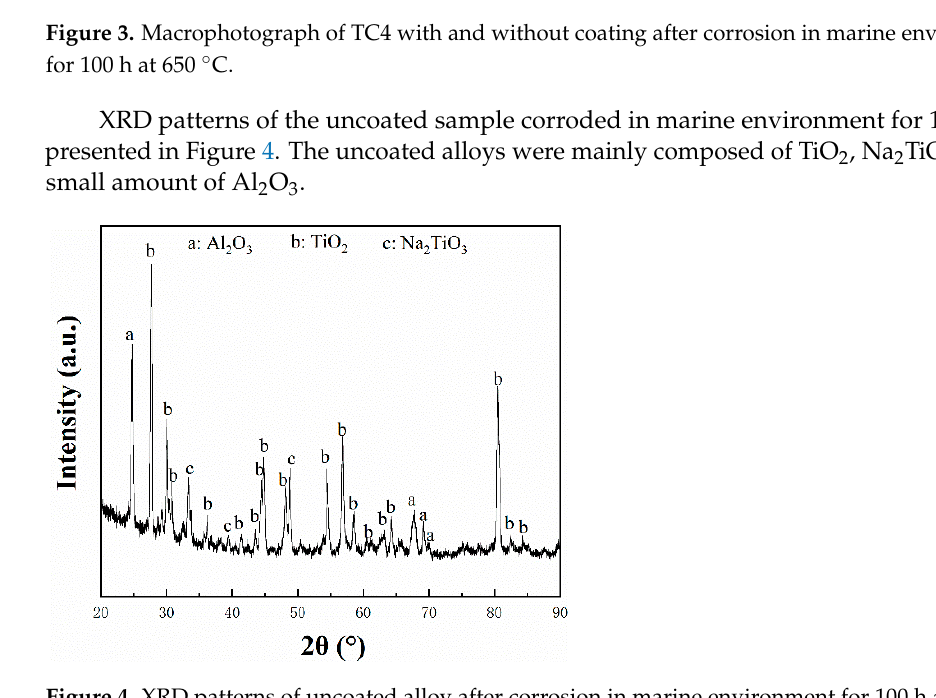
Figure 4. XRD patterns of uncoated alloy after corrosion in marine environment for 100 h at 650 °C.